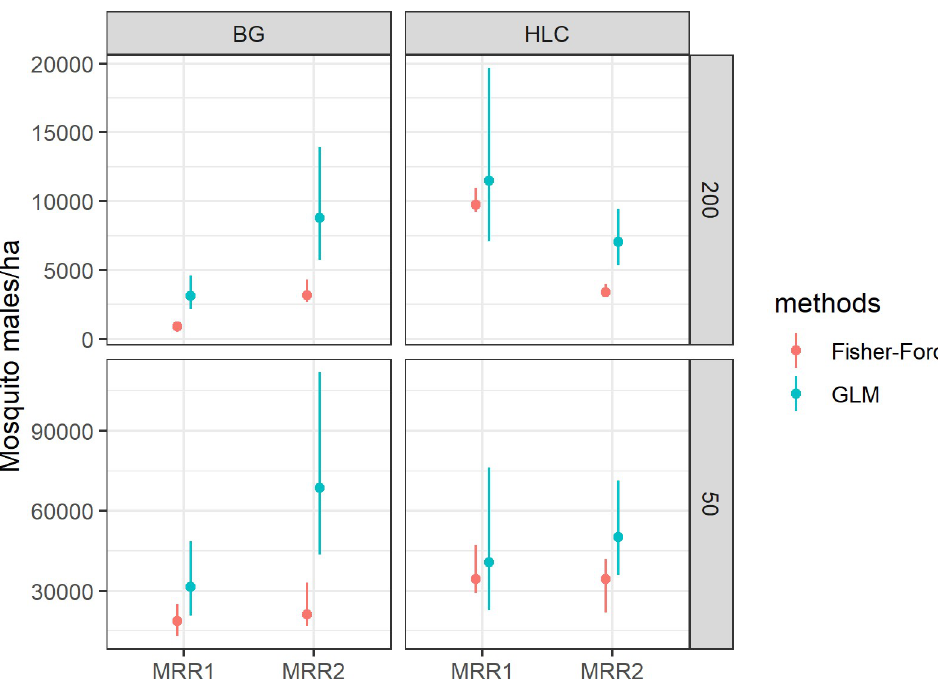
Fig 6. Wild Aedes albopictus population size on Procida Island estimated based on mark-release-recapture (MRR) experiments within either a 200m- and a 50m-areas around release site. Blue lines = GLM-based estimates; red lines = Fisher-Ford based estimates; dots = mean value of mosquito males/hectare; vertical segments = 95% confidence intervals using percentile bootstrap (red), using equation [5, S1 Text] (blue).